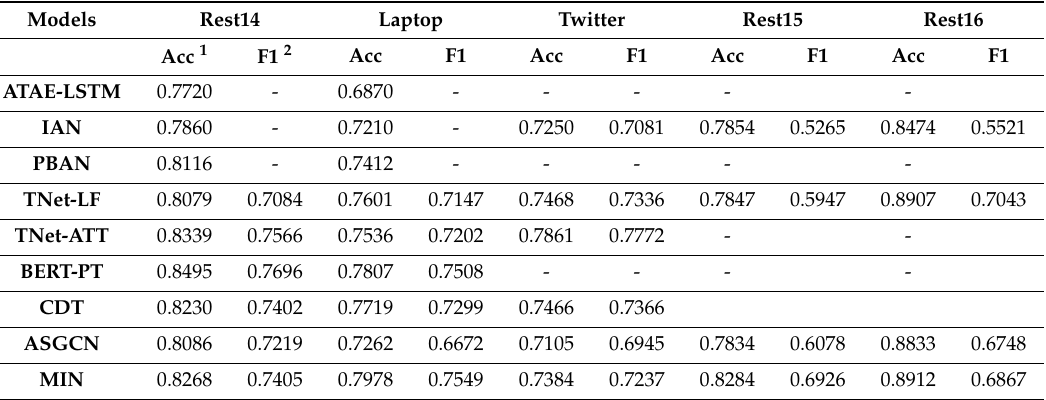
Table 3. The experimental